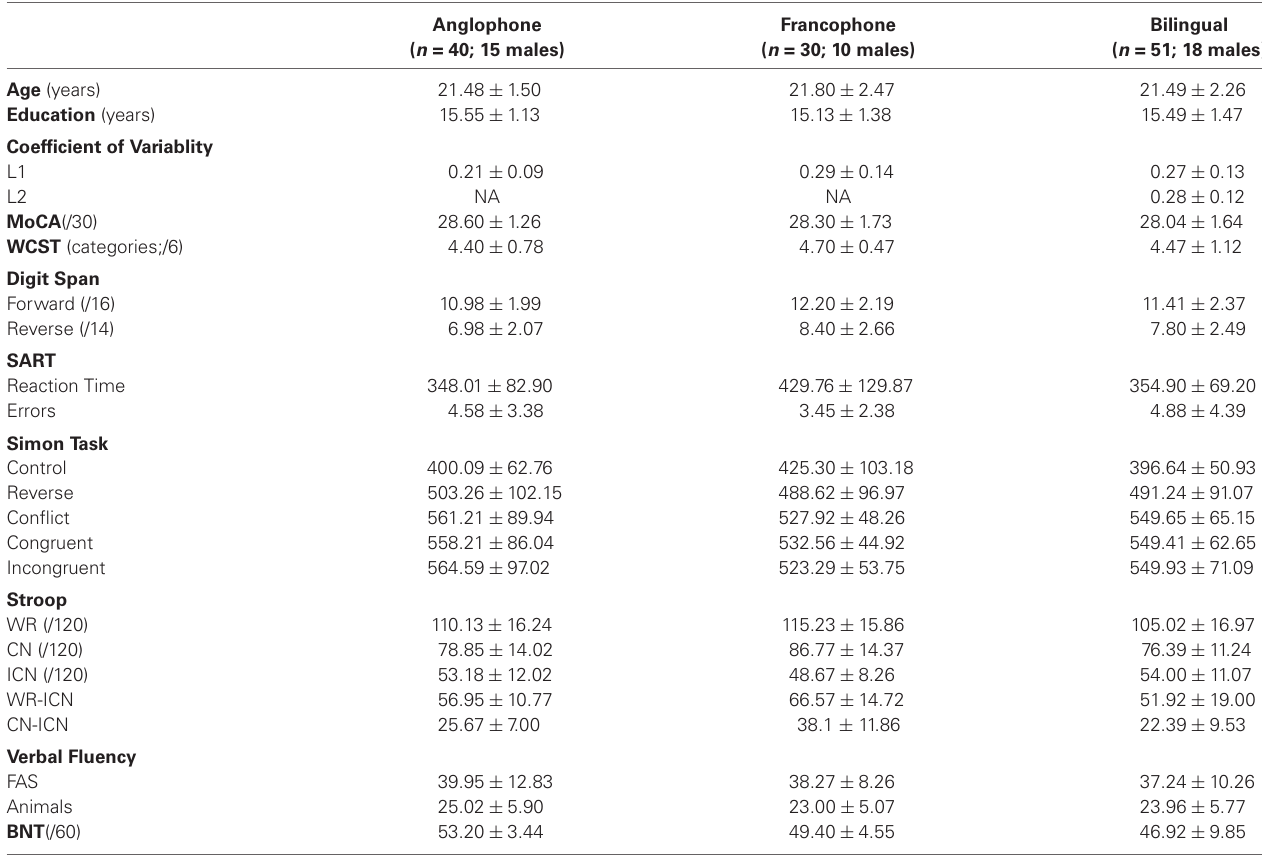
Table 2 | Young adult demographic, neuropsychological, executive function, and language task performance (mean ± standard deviation)